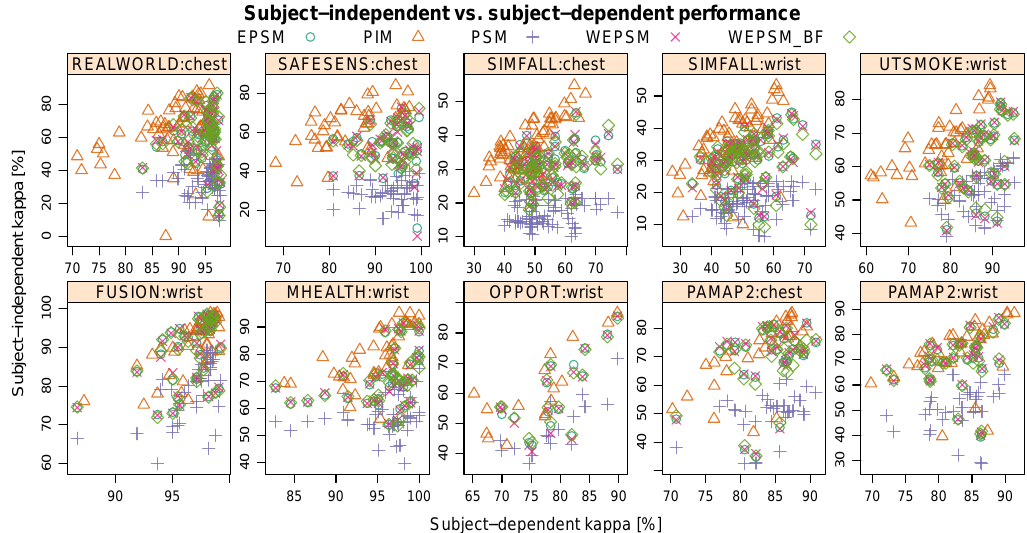
Figure 3. Subject-independent (vertical axis) versus subject-dependent (horizontal axis) κ (%) across all learning algorithms. Axes have been scaled to encompass the data for improved visibility. Note how the subject-dependent performance of (E)PSMs tends to be better (further to the right) than that of PIMs, and there is a clear difference in subject-independent performance between PIMs and